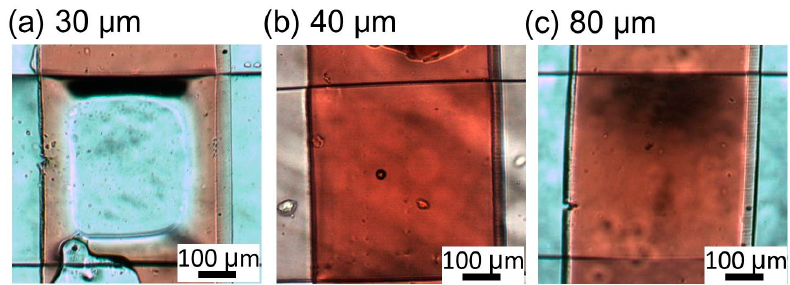
Figure 11. Reopened microvalves after pressure relief for membrane thicknesses of ( a ) 30; ( b ) 40; and ( c ) 80 μ m.